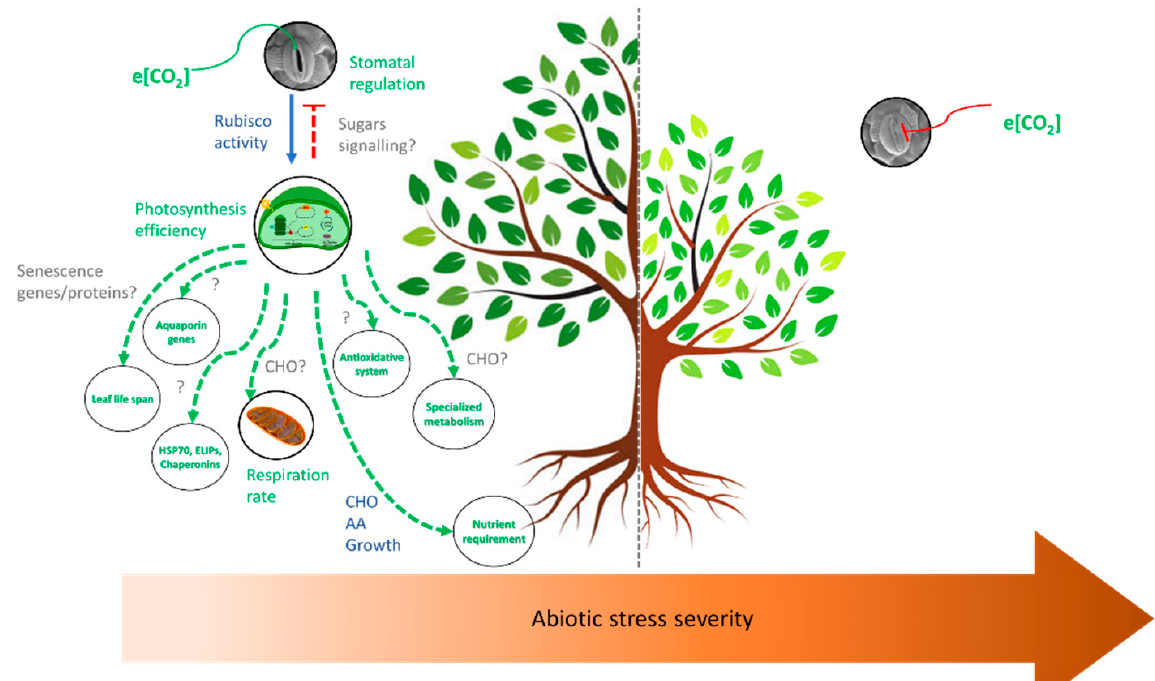
Figure 2. The main effects triggered by elevated CO 2 according to abiotic stress severity. Elevated